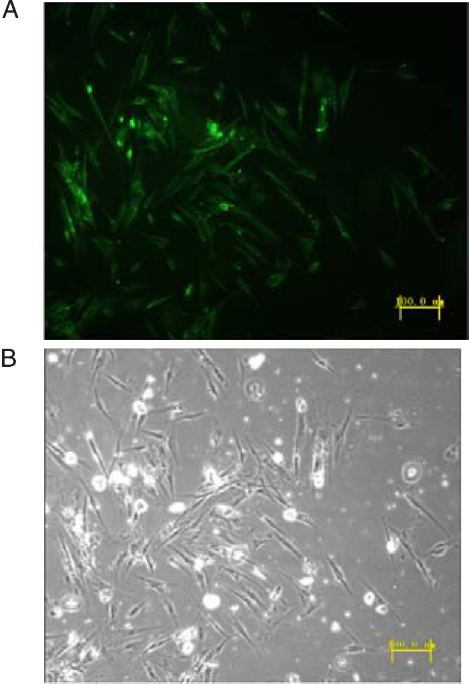
Figure 2. A , The successfully infected stromal cells emitted green fluorescence under a fluorescence microscope. The per - centage of EmGFP-positive cells was 80-90%. B , Normal light